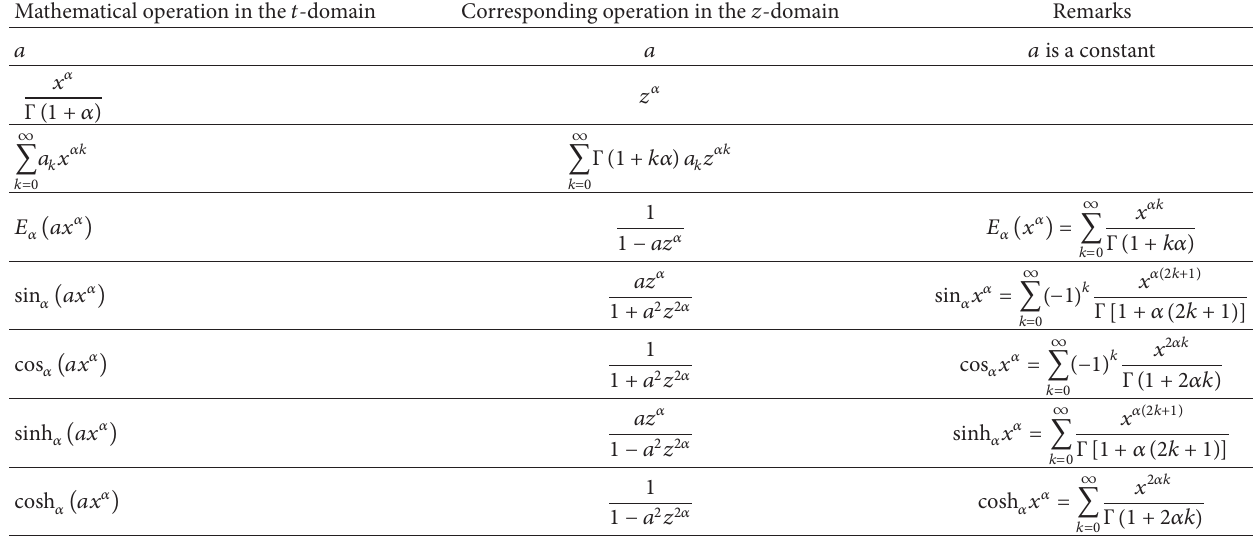
Table 1: Local fractional Sumudu transform of special